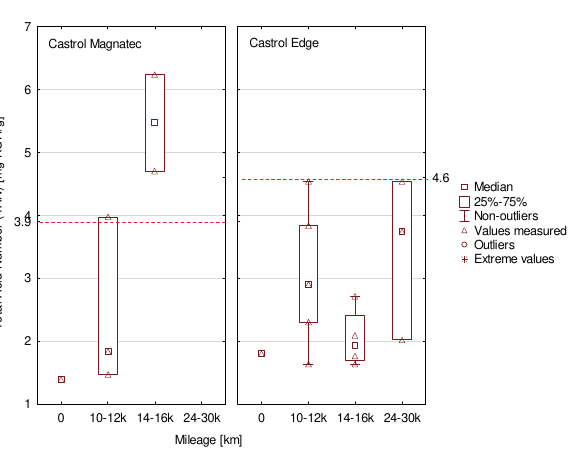
Fig. 4. The Total Acid Number analysis for the engine oils tested Oxidation is a natural process occurring during the ser- vice-life of oil. Too high degree of oil oxidation results in oil degradation, loss of its lubricating properties and a de- crease in corrosion protection. Among Castrol Magnatec 10W/40 oil samples tested, only one of them exceeded the assumed critical value (CMG03 – 0.43 Abs/0.1 mm). In the Castrol Edge 5W/30 group, two samples exceeded the limit value (CED03 – 0.46 Abs/0.1 mm and CED12 – 0.45 Abs/0.1 mm). The test results showed an upward trend in oxidation depending on the degree of oil use. The degree of oxidation of the engine oils tested is presented in Fig. 5.